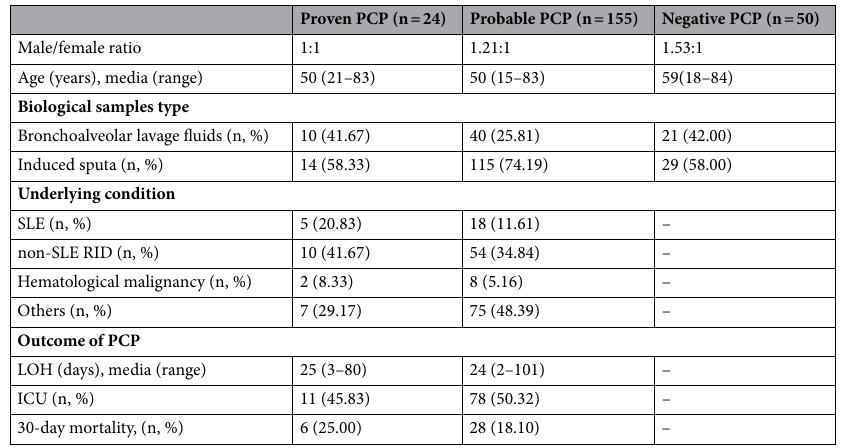
Table 1. Patient characters of BG groups. SLE systemic lupus erythematosus, RIG rheumatic immunity diseases, LOH length of hospitalization, ICU intensive care